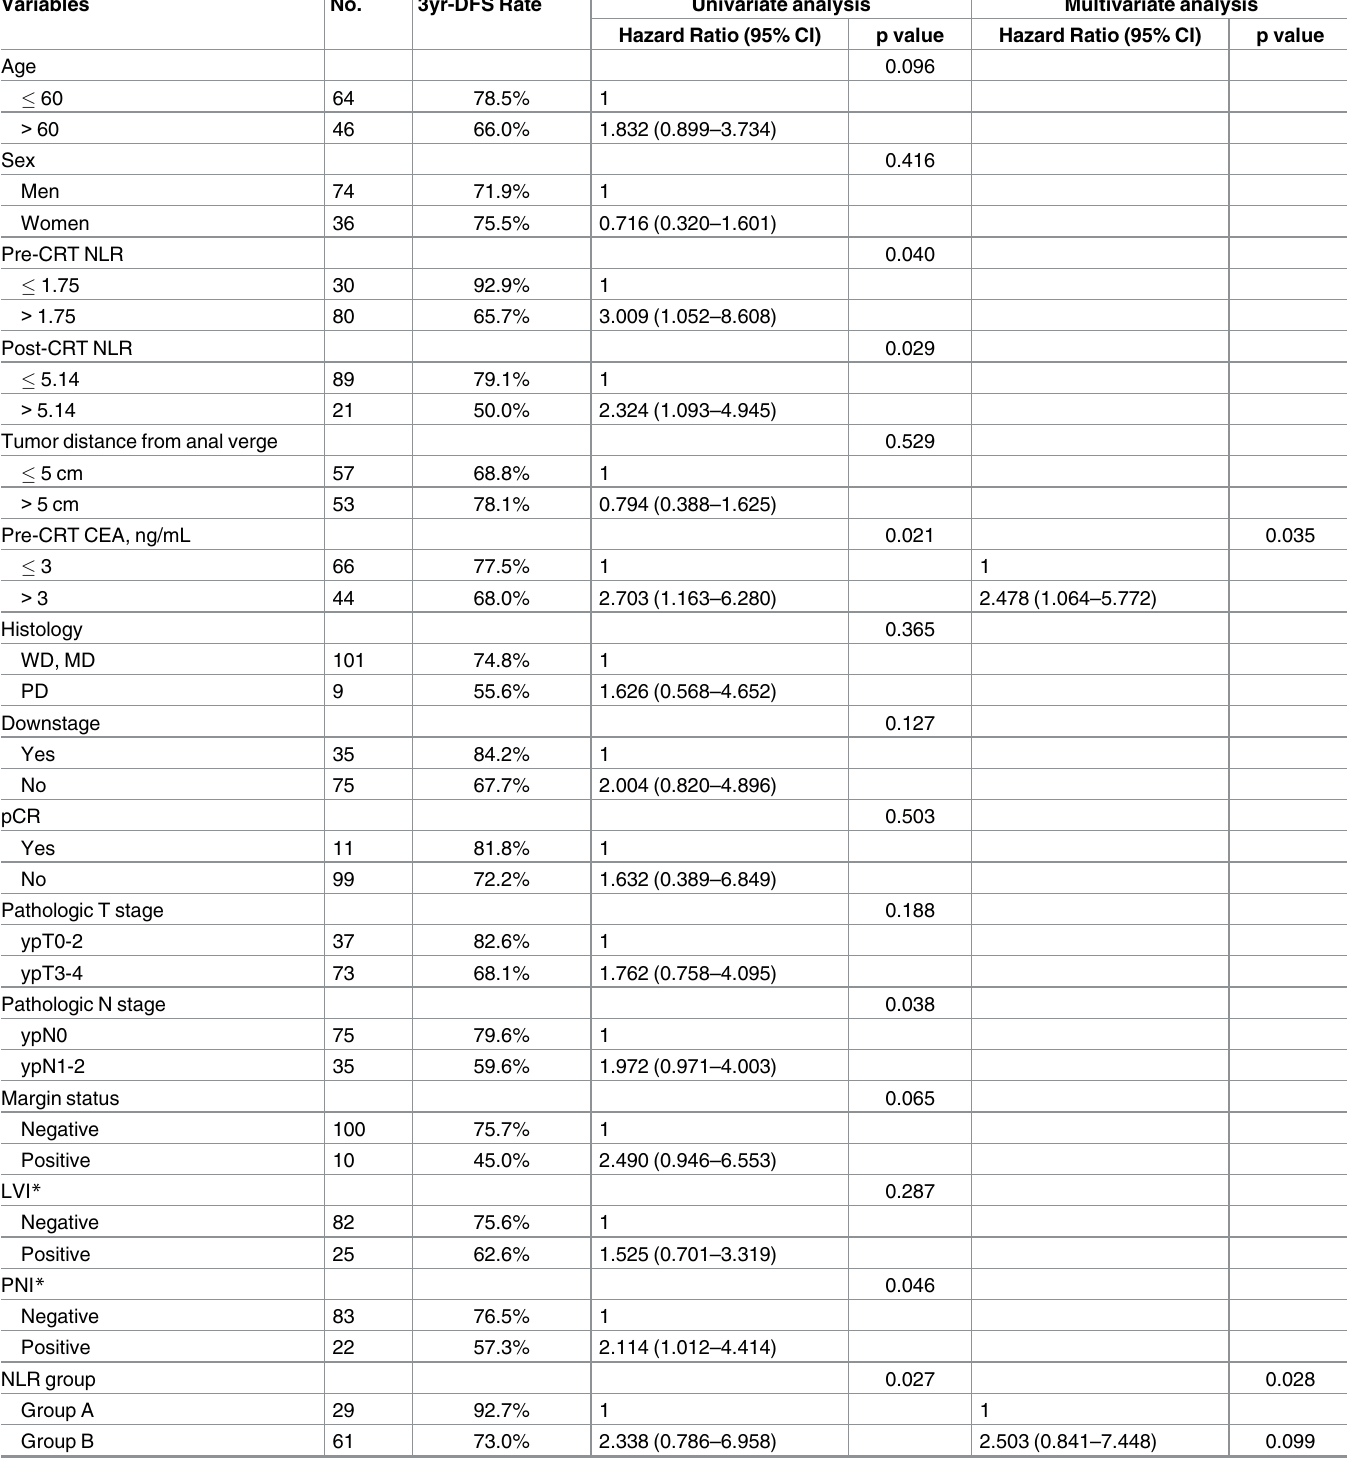
Table 3. Clinicopathologic factors that influence